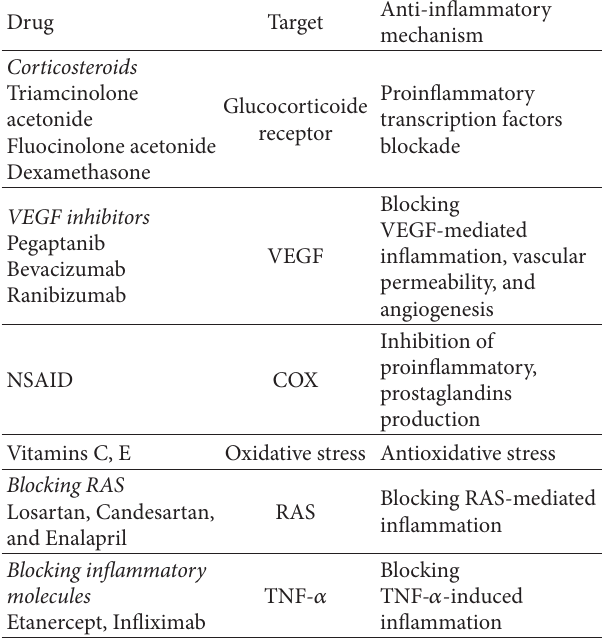
Table 2: Anti-inflammatory therapy of diabetic